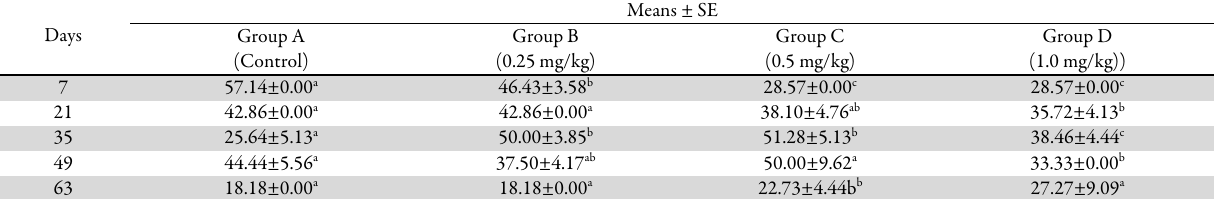
Table 3. Mean serum high density lipoprotein cholesterol concentration (mg/dl) of albino rats given graded doses of whole quail egg per kilogram body weight (± SEM) Days